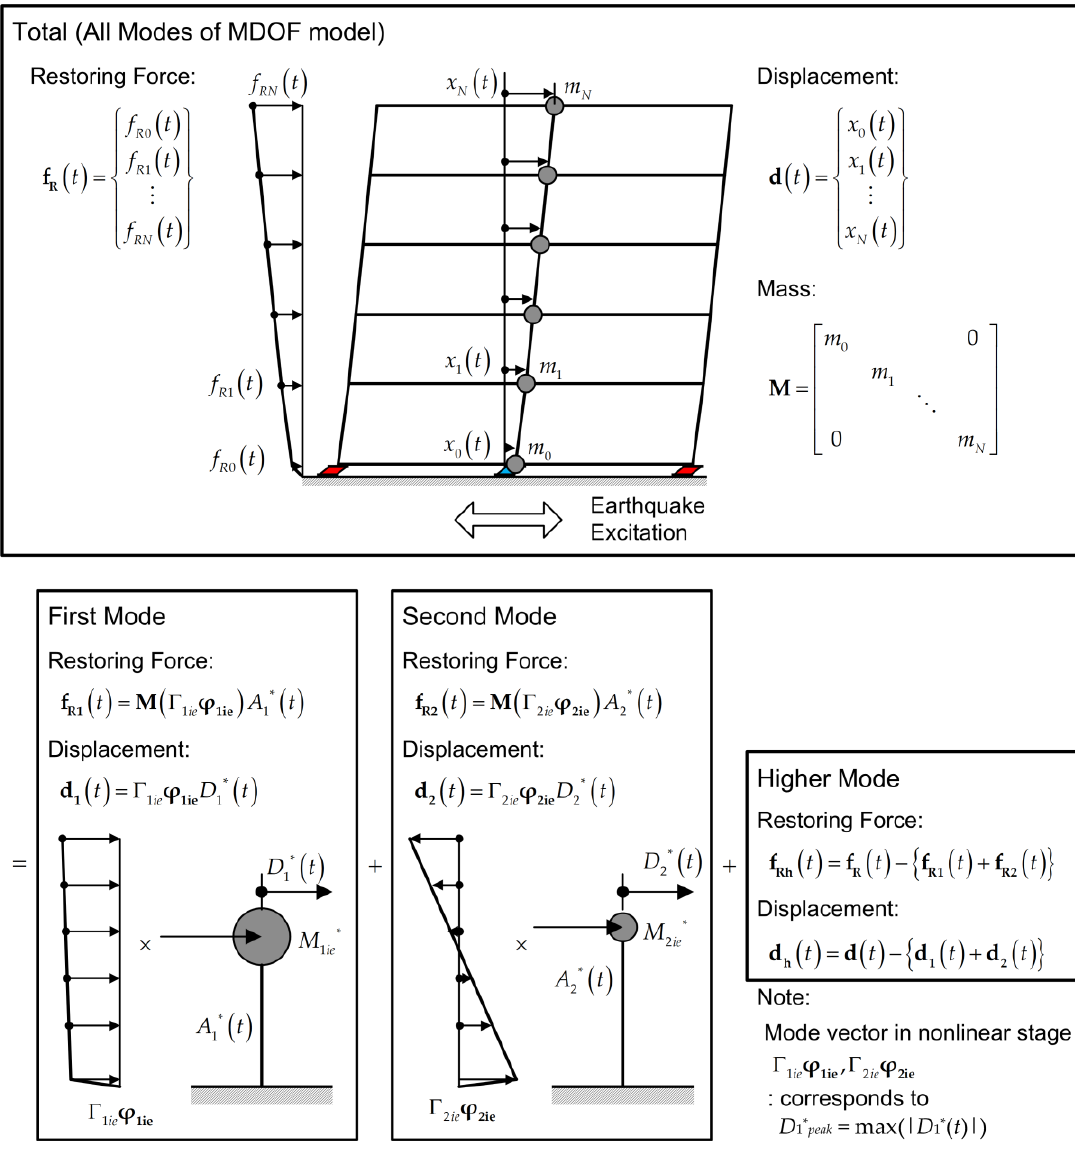
Figure 8. The concept of the calculating modal response.